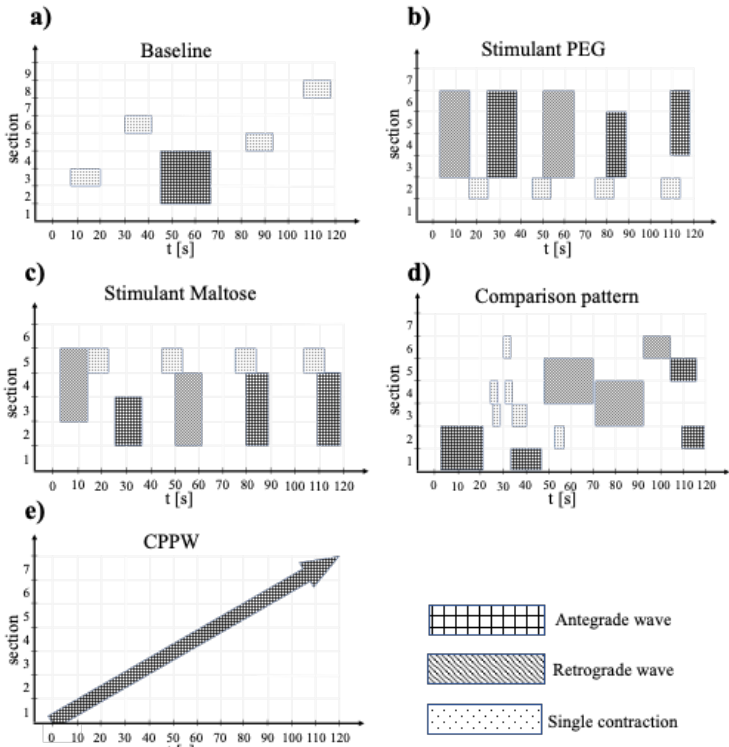
Figure 4. Illustration of the different motility pattern, where ( a ) is the Baseline, ( b ) the Stimulant PEG, ( c ) the Stimulant Maltose, ( d ) the Comparison pattern and ( e ) the CPPW motility pattern. Here, the x-axis represents the time and duration of the actions taking place and the y-axis the colon section ( haustra ) addressed. The different actions are indicated by different hatches. Table 5. Model parameter motility